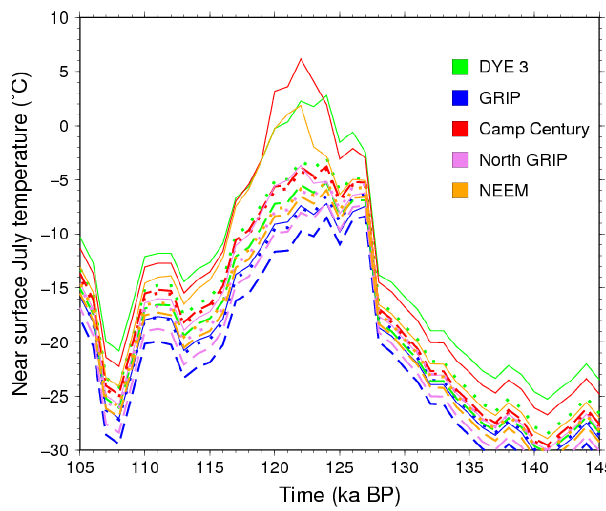
Fig. 8. July temperature evolution during the LIG at the deep ice core sites. Plain line: no-anomaly Fig. 9. July temperature evolution during the LIG at the deep ice experiment; Dashed line: CNRM anomaly; dotted line: IPSL anomaly. Anomaly experiments always core sites. Plain line: no-anomaly experiment; dashed line: CNRM suggest lower values for July temperature. Melt may potentially occur at Dye 3, Camp Century and anomaly; dotted line: IPSL anomaly. Anomaly experiments always NEEM sites, even in the anomaly method. suggest lower values for July temperature. Melt may potentially oc- cur at Dye 3, Camp Century and NEEM sites, even in the anomaly 36